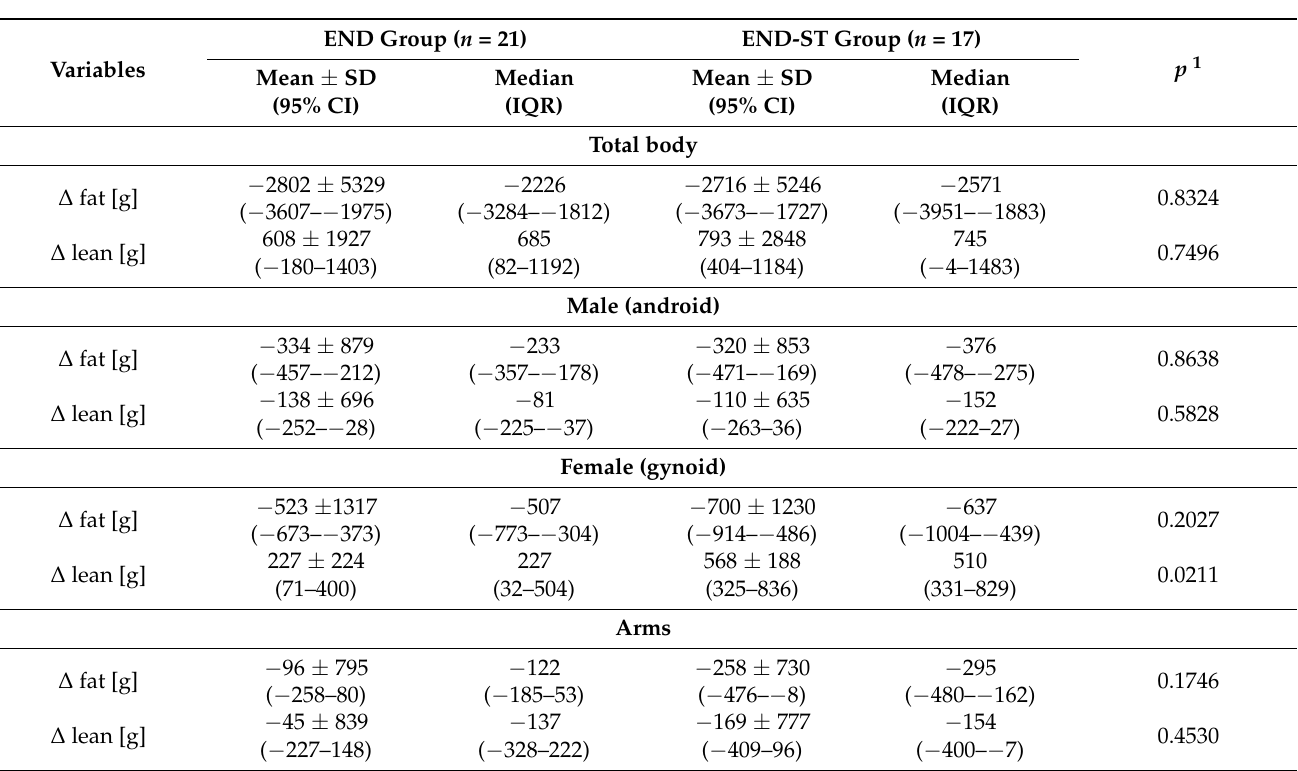
Table 7. Comparison of the differences ( ∆ ) in the effect of endurance and endurance-strength training on body